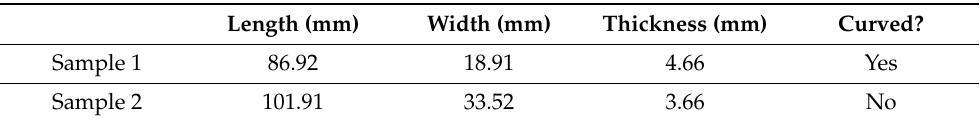
Figure 5. Flint blades used for the measurements. ( a ) Sample 1; ( b ) Sample 2. Photo & graphic: Tayong Boumda. Table 1. Dimensions and form of the flint blades